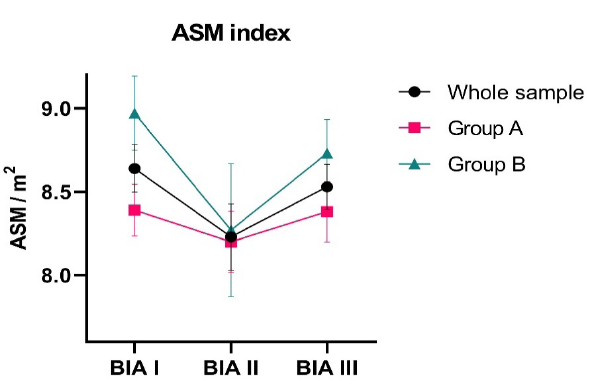
Fig. 2. The average change in the proportion of fat mass dur- ing the measurement. Data and error bars represent the mean ± SEM.